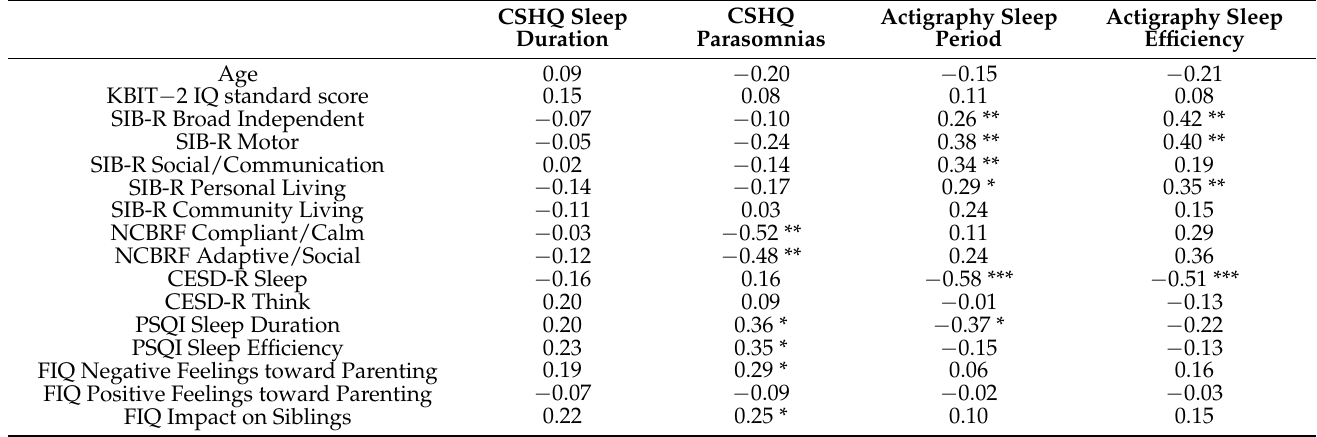
Table 2. Correlations between demographic or independent variables and dependent